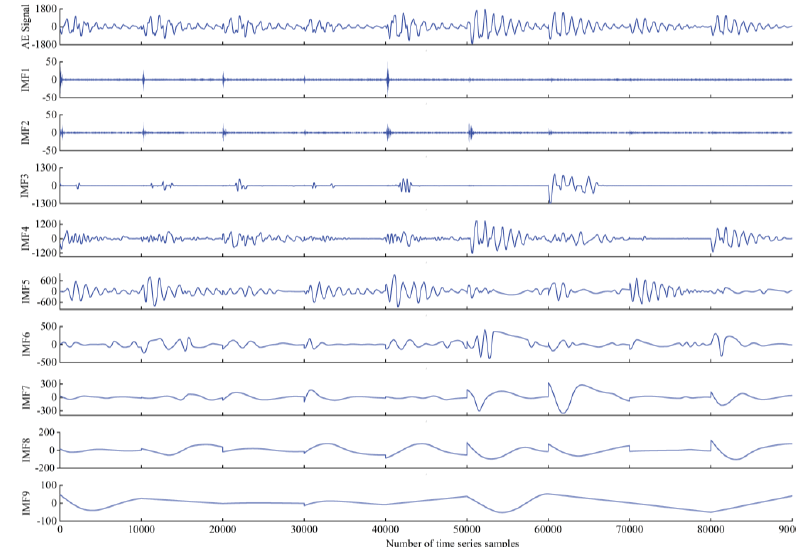
Figure 6. VMD algorithm decomposition results.